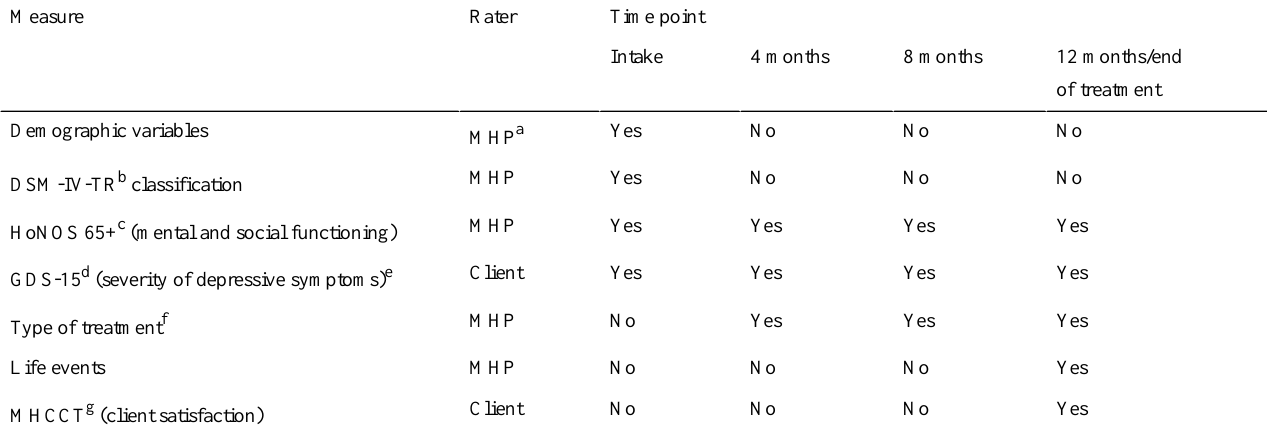
Table 1. Measurement overview of Mental Health Care Monitor Older Adults